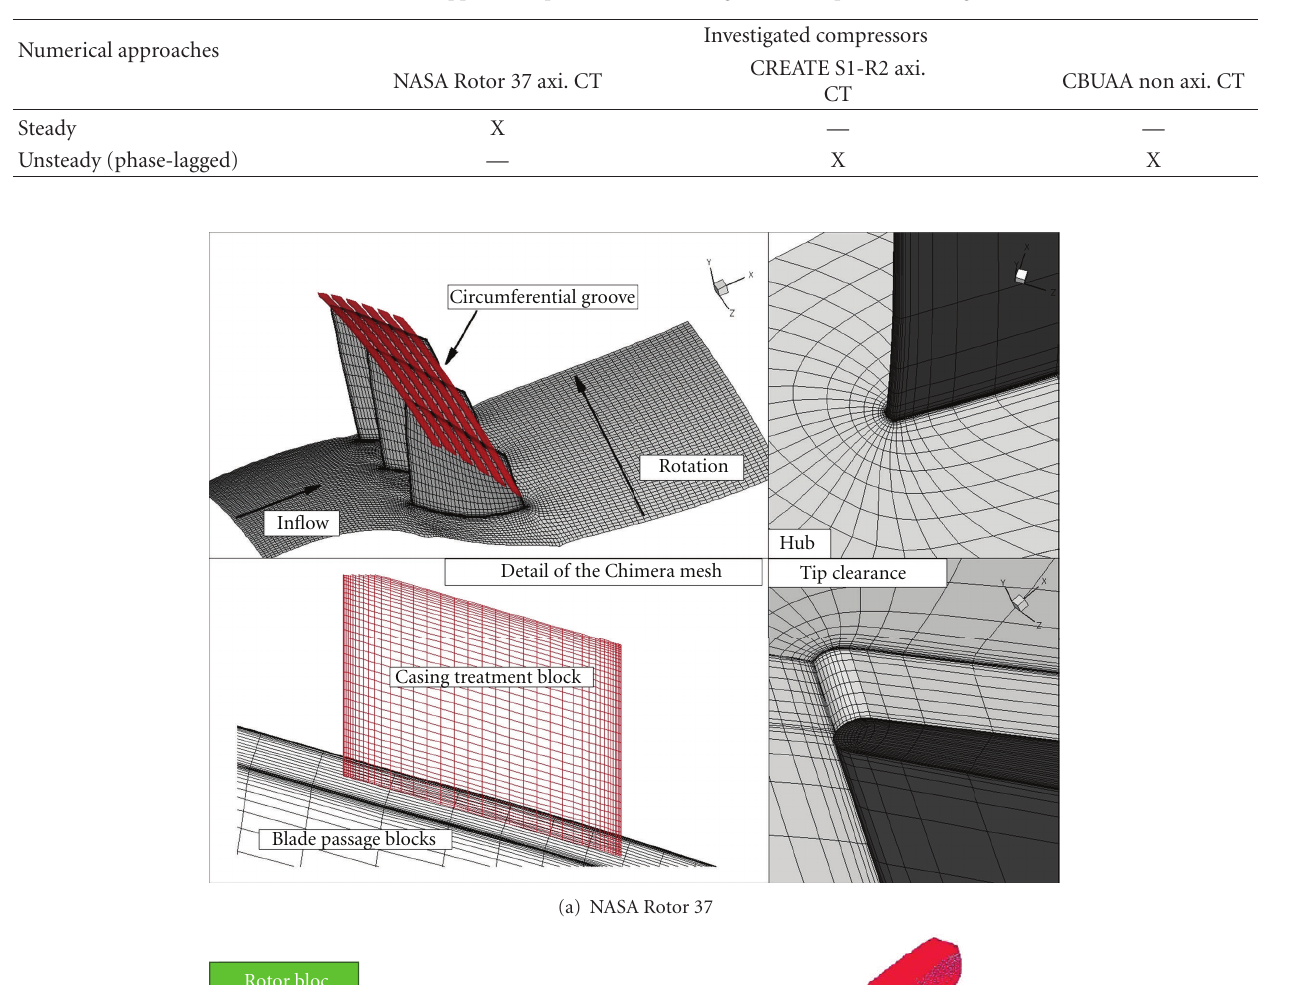
Table 6: Numerical approaches performed according to the compressor investigated.